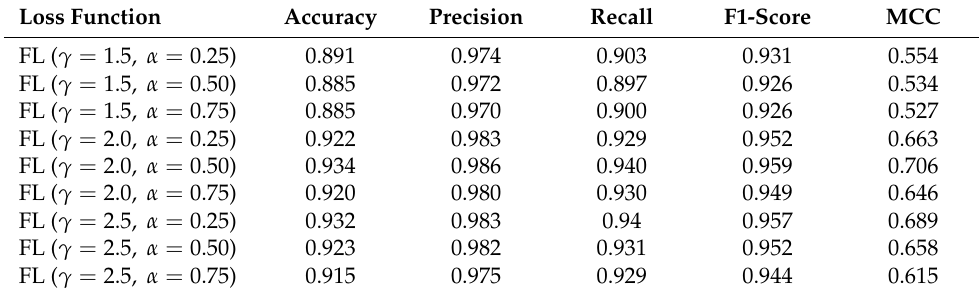
Table 11. Classification results with HSI dataset for varying cost functions and respective parameter sets. (patch size parameter S = 100, 2D convolutions, see Figure A3 for network topology). Loss Function Accuracy Precision Recall F1-Score MCC FL ( γ = 1.5, α =